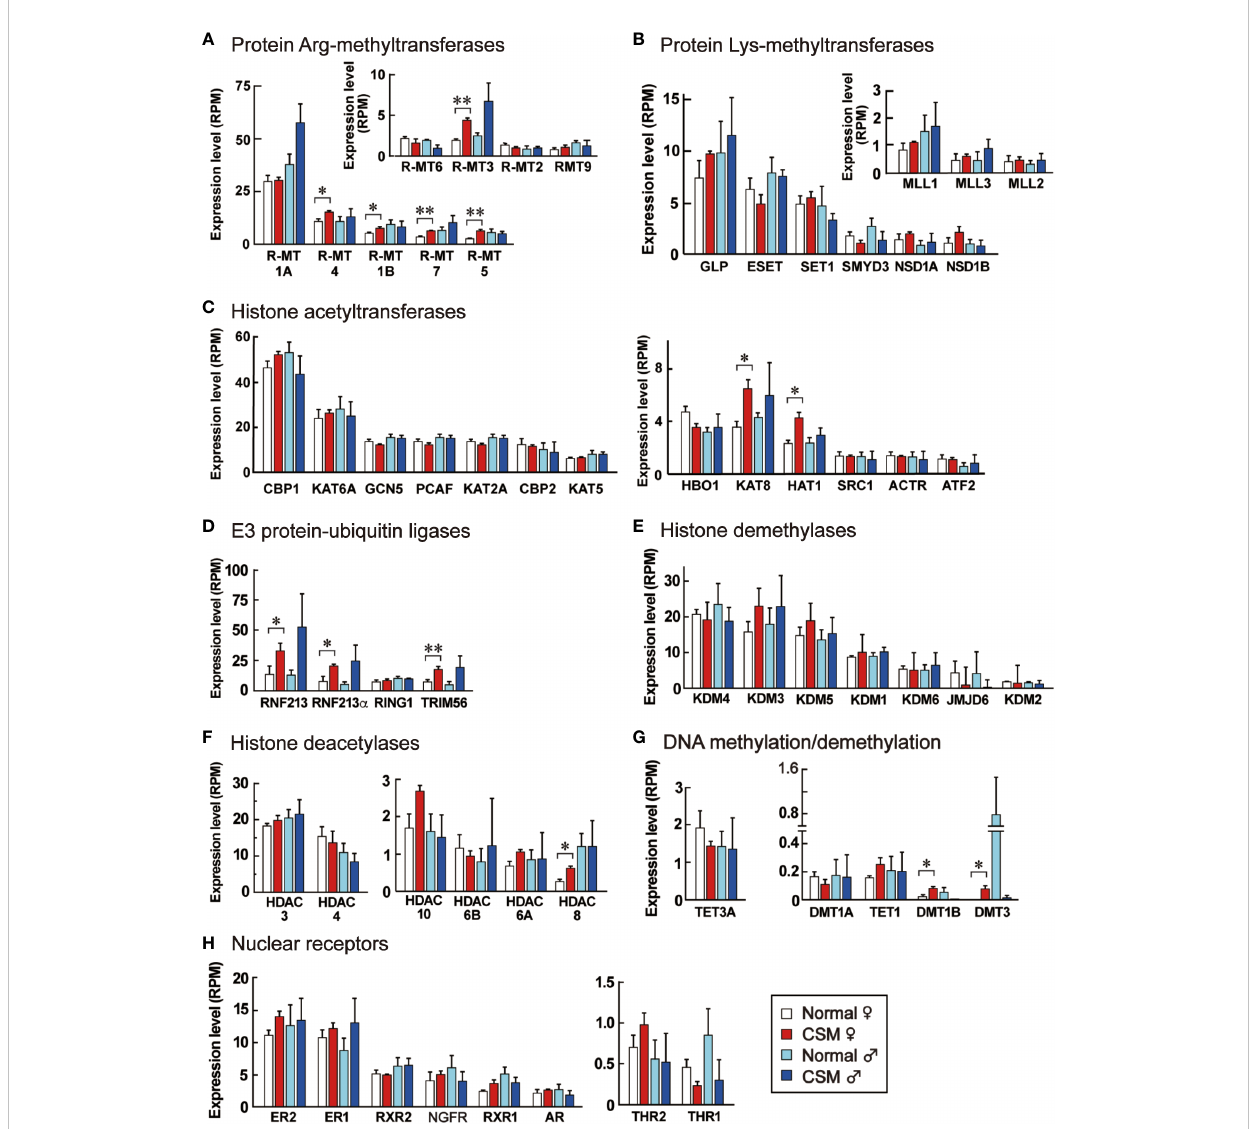
FIGURE 6 Expression levels of enzymes for epigenetic modi fi cation and nuclear receptors in the ganglia of normal and CSM snails. RPM of enzymes for epigenetic modi fi cations and nuclear receptors expressed in Reishia ganglia are shown. They were grouped into protein Arg-methyltransferases